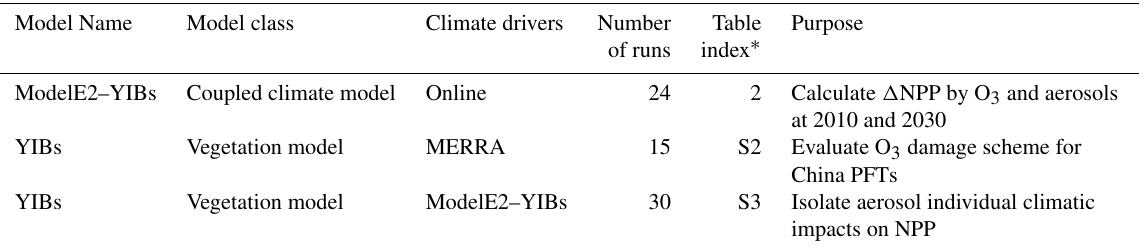
∗ Table index refers to the tables in the main text and the